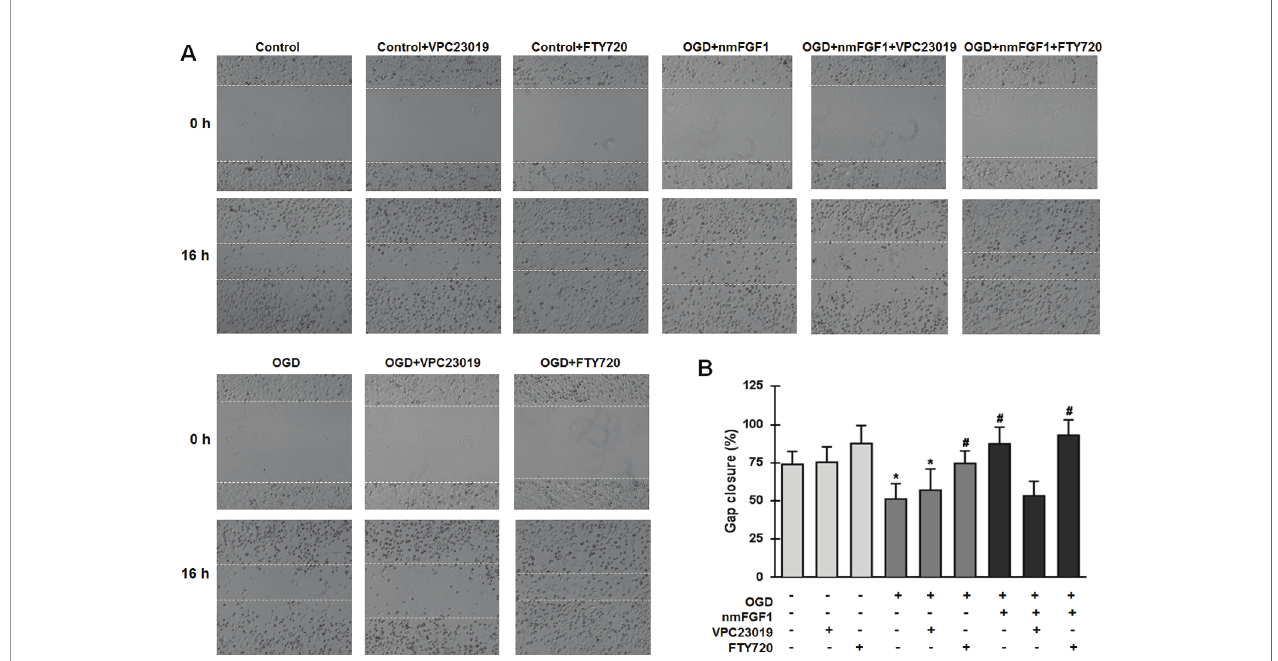
FIGURE 7 | Non-mitogenic fi broblast growth factor 1 (nmFGF1) promoted wound repair in oxygen-glucose deprivation (OGD)-exposed HBMECs via S1P signaling pathway. (A) Representative images showing the migration of OGD-exposed cells treated with the S1P1 inhibitor VPC23019 (40 nM) and agonist FTY720 (50 nM) in the presence or absence of nmFGF1. (B) Quanti fi cation of the effects of the S1P1 inhibitor VPC23019 (40 nM) and agonist FTY720 (50 nM) in the presence or absence of nmFGF1 on wound healing. Date are means ± SEM (n = 6). *p < 0.05 compared to control group, # p < 0.05 as compared to the OGD-treated